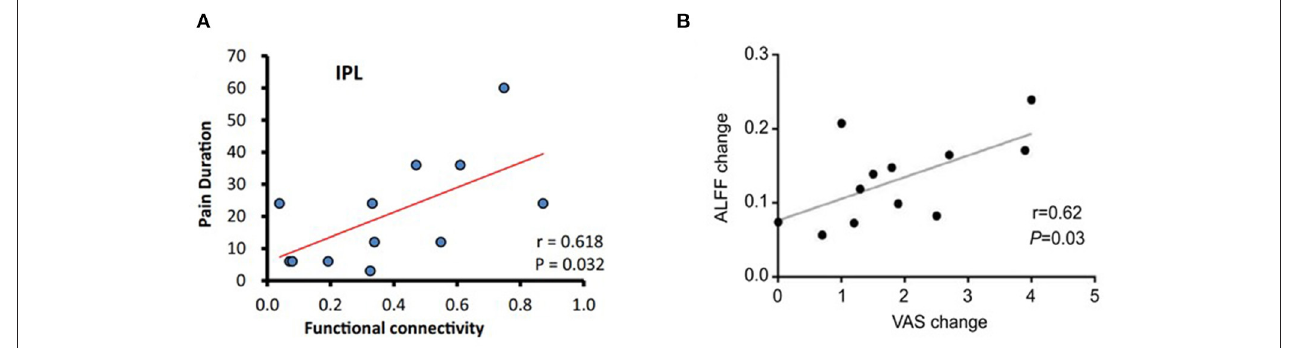
FIGURE 2 | Correlation analysis in some studies (Xiang et al., 2019; Liu et al., 2020). (A) The PCC-seeded FC was positively correlated with pain duration in the right inferior parietal lobule at baseline in LBP patients. (B) There was a significant correlation between ALFF change in the left insular and VAS change after acupuncture treatment. ALFF, amplitude of low-frequency fluctuation; FC, functional connectivity; LBP, low back pain; PCC, posterior cingulate cortex; VAS, visual analog